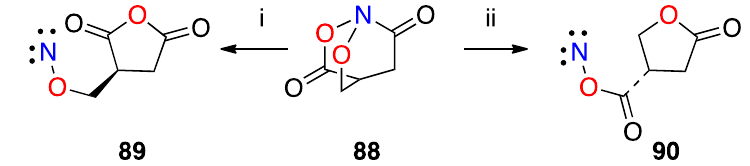
Scheme 17. HERON migrations of alkoxyl in the absence of resonance. Table 8. B3LYP/6-31G(d) activation energies ( E A ), resonance energies (RE TA ), and rearrangement energies ( E rearr ) for HERON reactions of model anomeric amides and tricyclic anomeric amides; all values in kJ mol − 1.